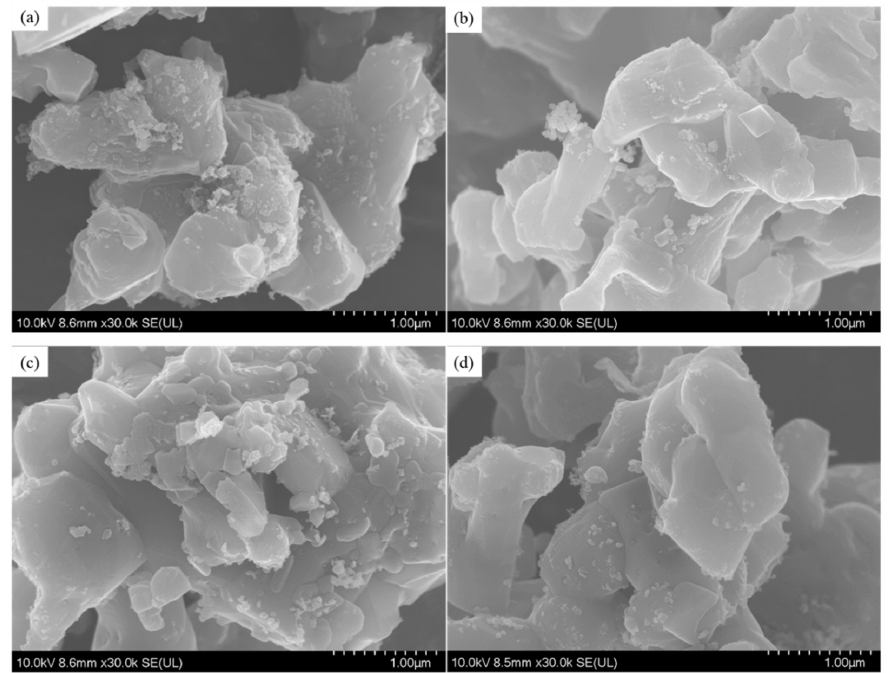
Figure 5. SEM images of samples sintered at 1000 °C for different holding times: ( a ) 0.5 h, ( b ) 1 h, ( c ) 1.5 h and ( d ) 2 h. Scale bars: 1 µM. ( c ) 1.5 h and ( d ) 2 h. Scale bars: 1 µ